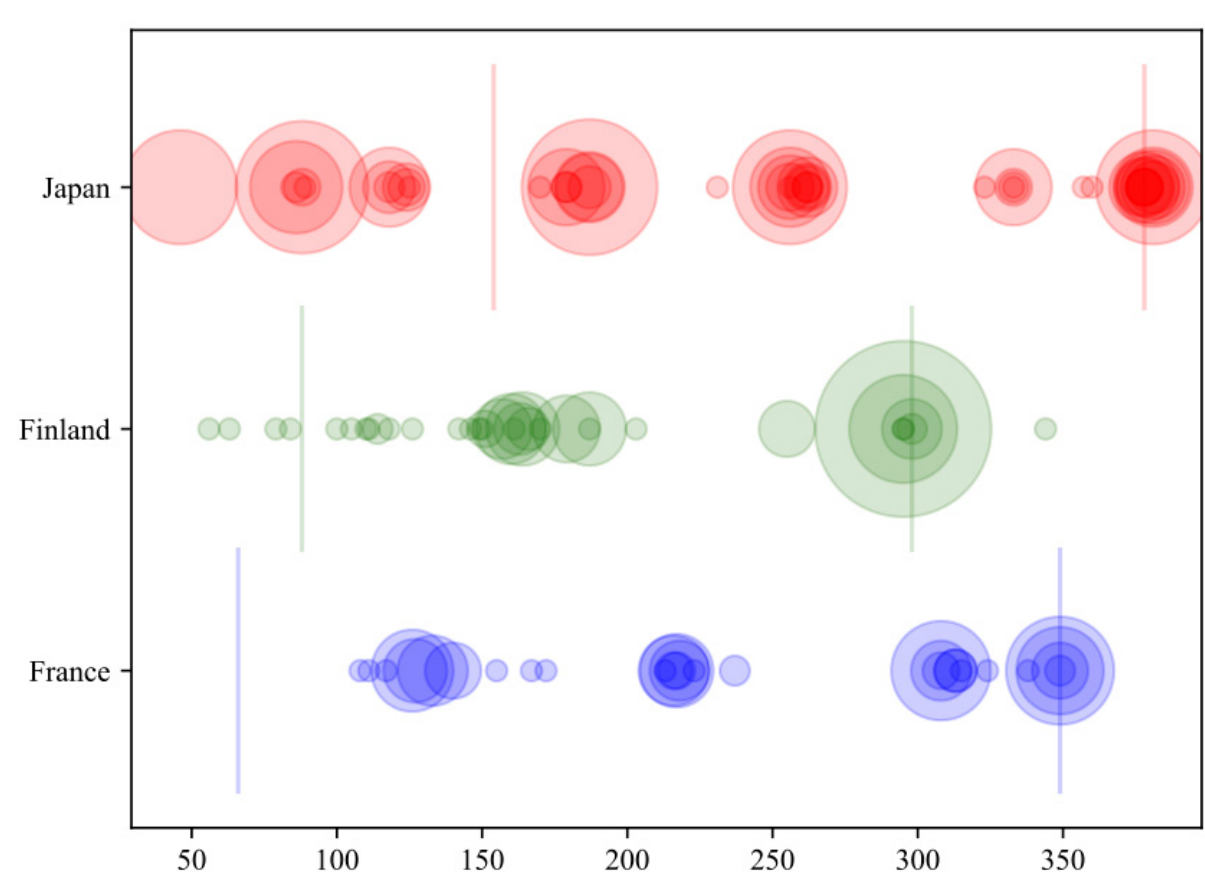
Figure 2. The timing of the sprint acceleration mechanical output measurements during the season. The x-axis represents the time (in days) from the start of the season (t = 0), the y-axis represents the groups (Finland = green, Japan = red, France = blue), the color of the circle represents the groups (Finland = green, Japan = red, France = blue), the size of the circle represents the number of measurements at the measurement session. The first vertical line represents the end of the pre-season and the second vertical line the end of the season, with color according to the